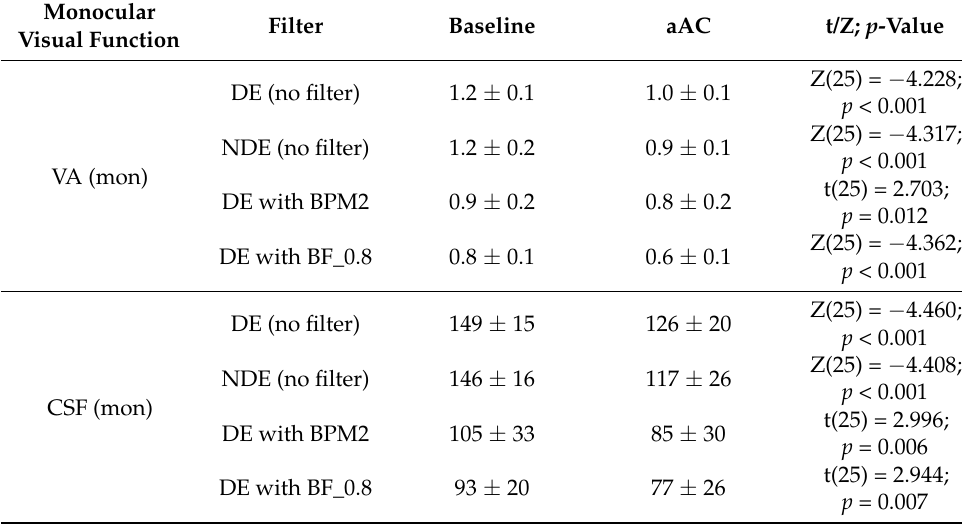
Table 1. Mean values of the monocular (mon) visual functions (Visual Acuity in decimal notation, VA; averaged Contrast Sensitivity Function, CSF; and Visual Disturbance Index, VDI) under two experimental conditions, baseline (no alcohol consumption) and aAC (after alcohol consumption), and for different monocular conditions (dominant eye, DE; non-dominant eye, NDE, dominant eye wearing the BPM2 fog filter, DE with BPM2; and dominant eye wearing the Bangerter foil, DE with BF_0.8). Standard deviations included and statistical results (t/Z) and p -values are